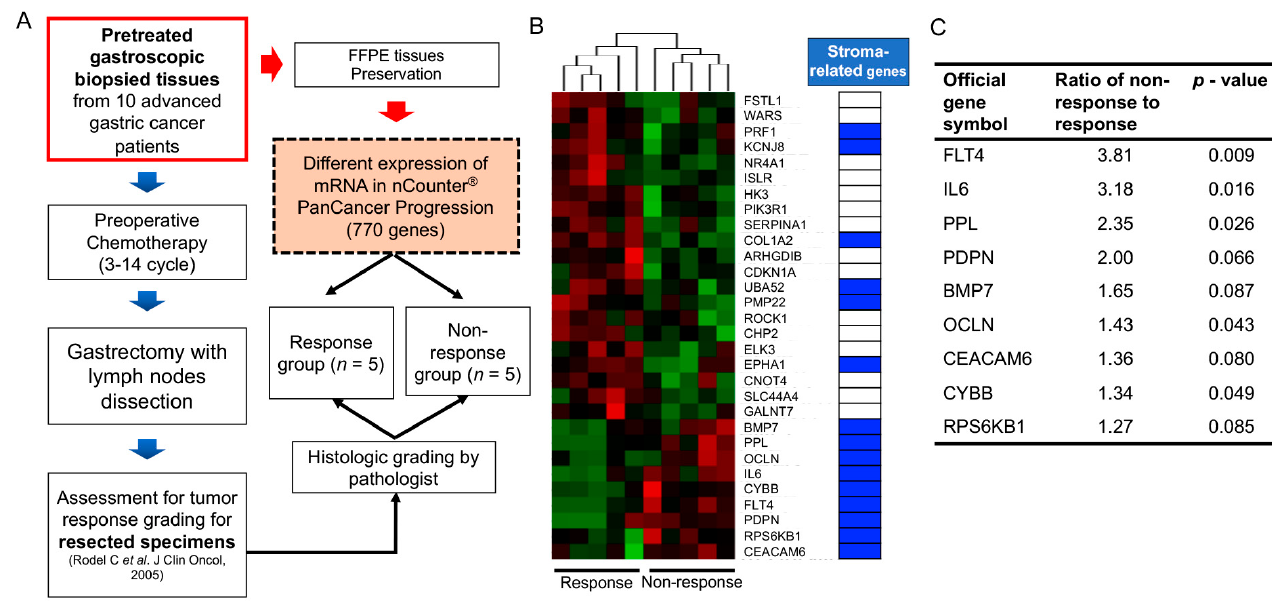
Figure 1. Gene expression patterns in pretreated gastroscopically biopsied tissues of patients who underwent preoperative chemotherapy (modified from Ham et al., 2019, Mol Cancer [15]. ( A ). Flow diagram presenting the study scheme for the comparison of gene expression patterns using the nCounter system between chemotherapy responders and non-responders. ( B ). Heatmap depicting different gene expression patterns between chemotherapy responders and non-responders. Blue-colored cells in the table to the right of the heatmap indicate stroma-related genes. ( C ). Nine stroma-related genes were found in non-responders.